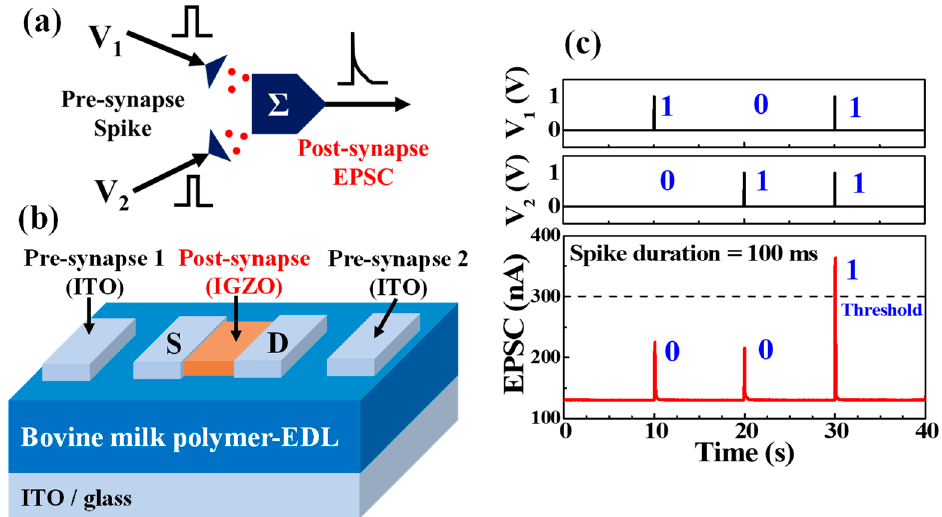
Figure 7. ( a ) Schematic diagram of synaptic weight integration. ( b ) Structure of two in-plane gated bovine-milk-based synaptic transistors for synaptic weight integration realization. ( c ) AND logic operation tuned by summation of two synchronous pre-synapse spikes.